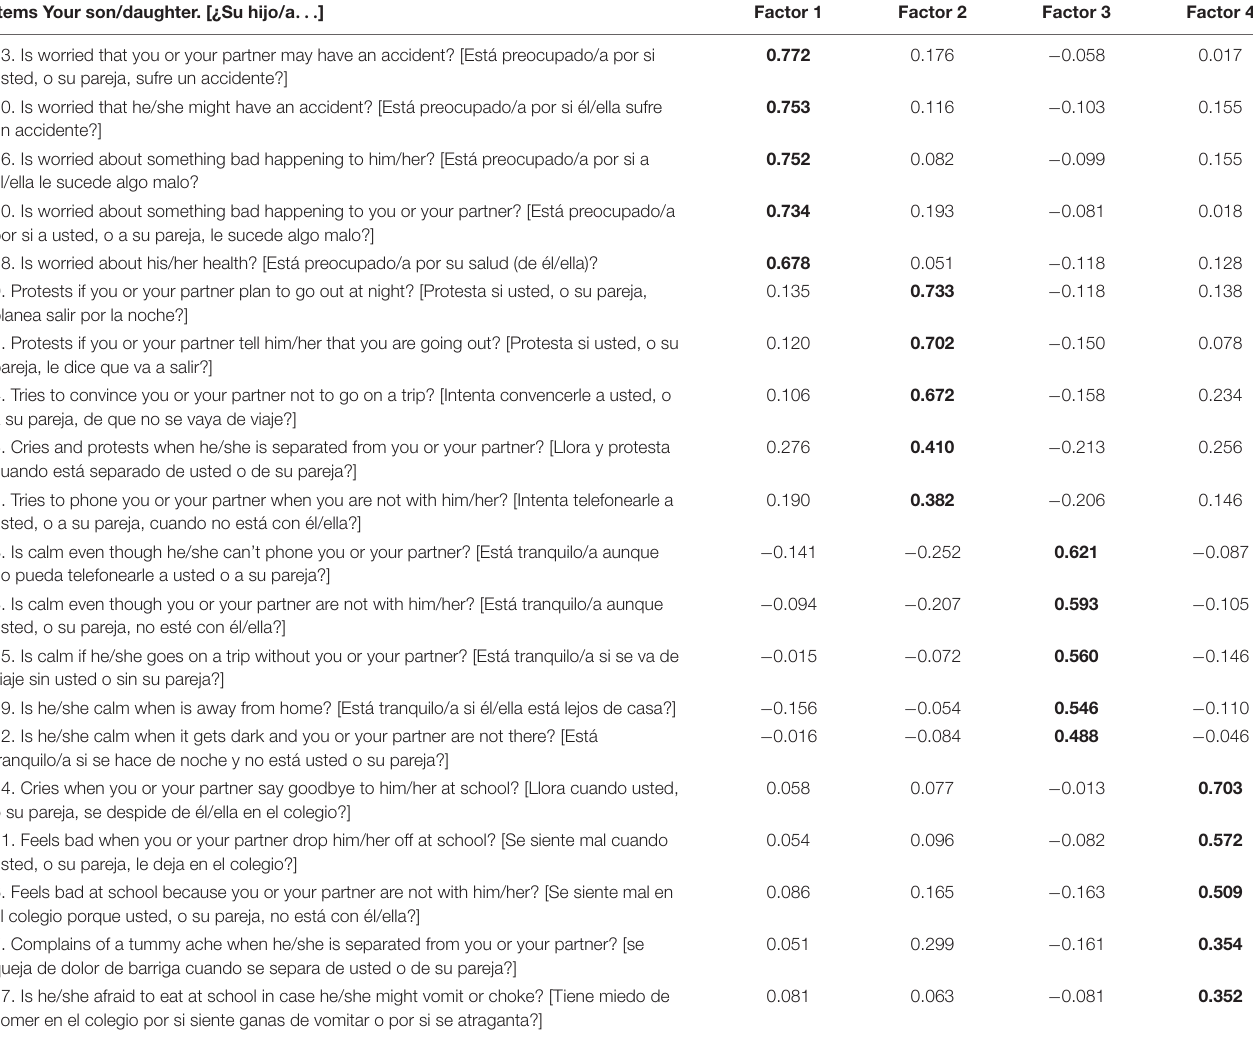
TABLE 1 | Exploratory factor